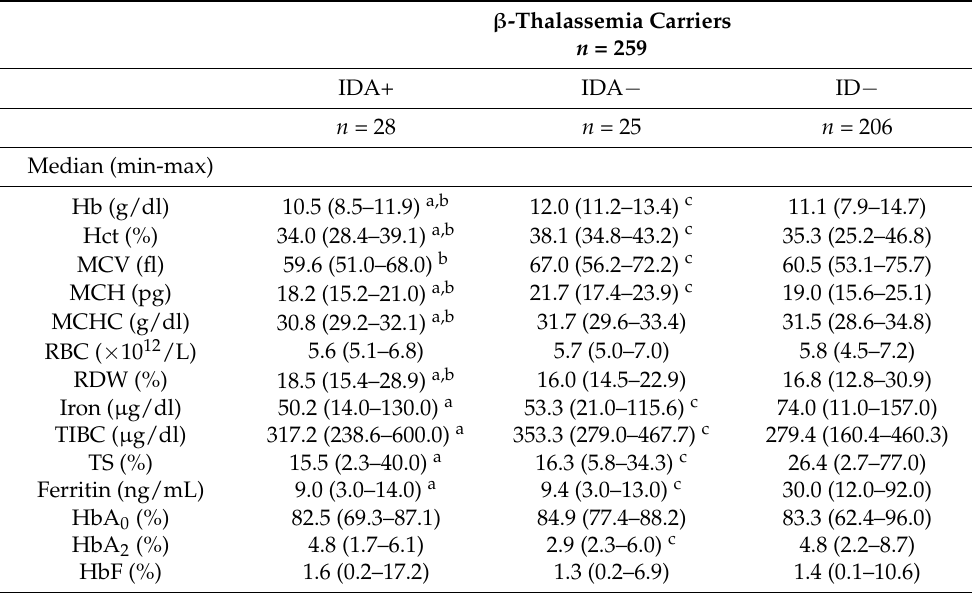
Table 2. Comparisons of erythrocyte parameters and other hematologic findings between the